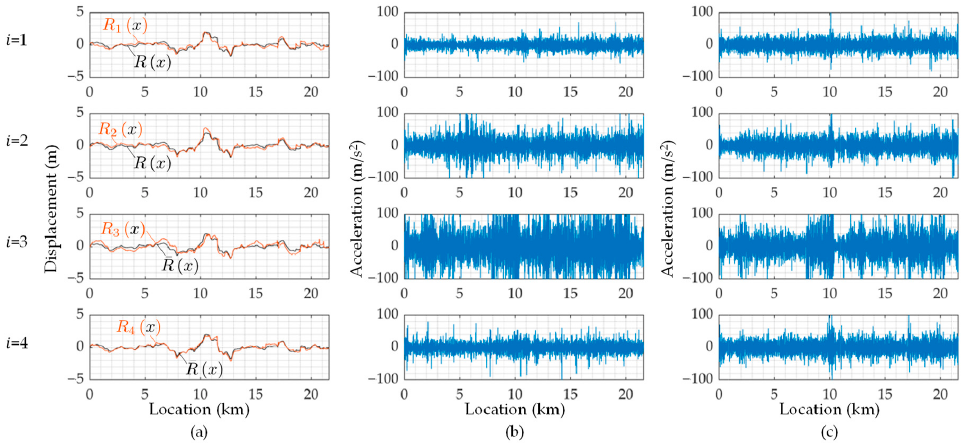
(cid:0) c (cid:1) ) = 5: ( a ) the road profiles, R ( x ) , estimated = 2 and ( k (cid:4673) = 2 and (cid:4672) (cid:3038) (cid:4673) = 5: ( a ) the road profiles, 𝑅 (cid:3036) (cid:4666)𝑥(cid:4667) , esti- i m m .. (cid:3040) (cid:3040) .. R i ( x ) , estimated from ˆ r i ( ω ) ; ( c ) the road profile .. r ( x )